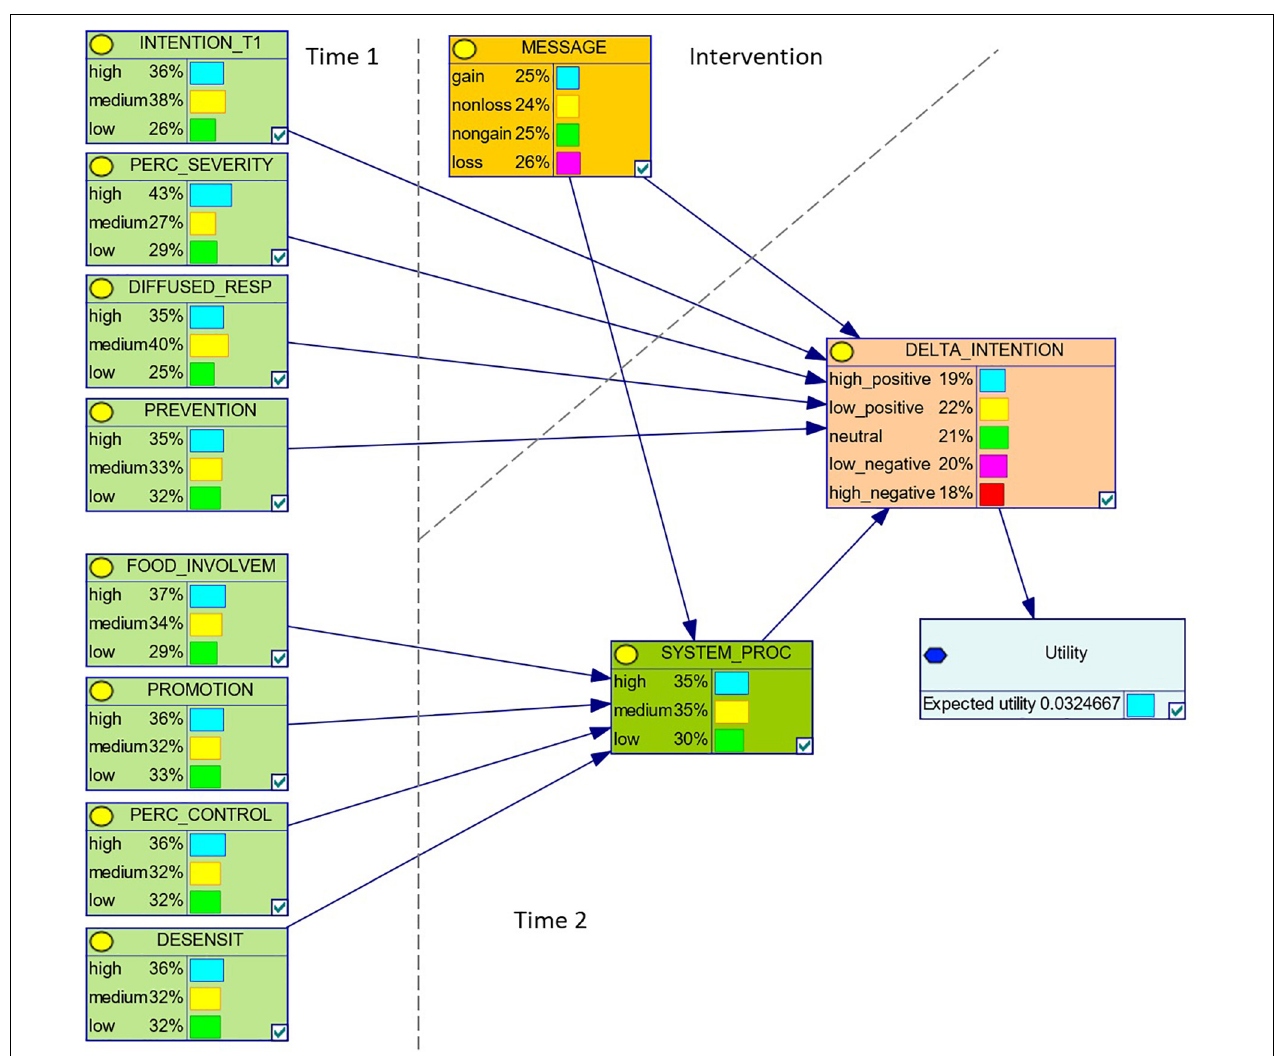
FIGURE 1 | The Dynamic Bayesian Network selected by the automated structure elicitation